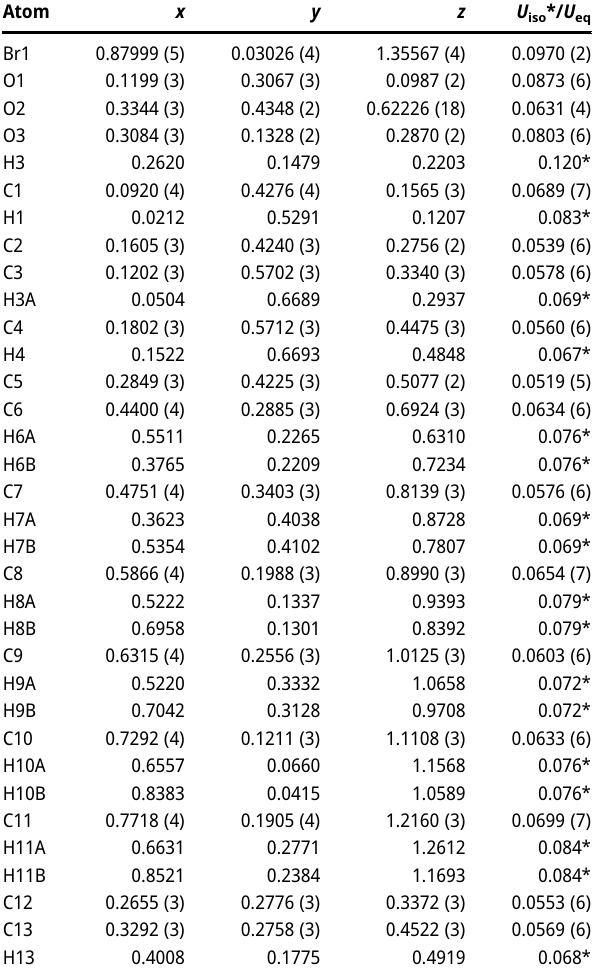
Table  : Fractional atomic coordinates and isotropic or equivalent isotropic displacement parameters (Å 